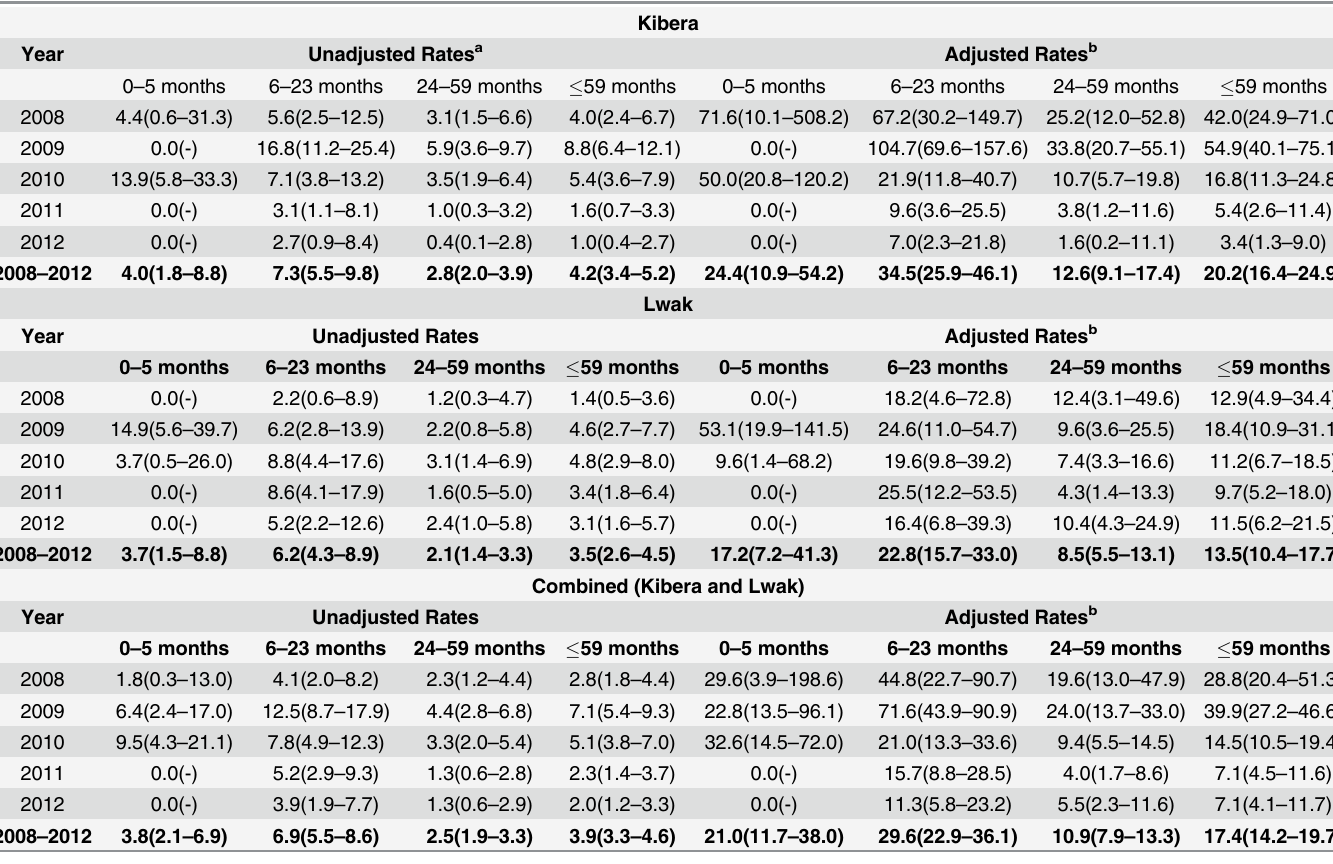
Table 4. Rate of Medically attended Acute Lower Respiratory Tract Illness (ALRI) a Attributable to Influenzab per 1000 Person-Years, by Site, Age Group and Year, Jan 2008 — Dec